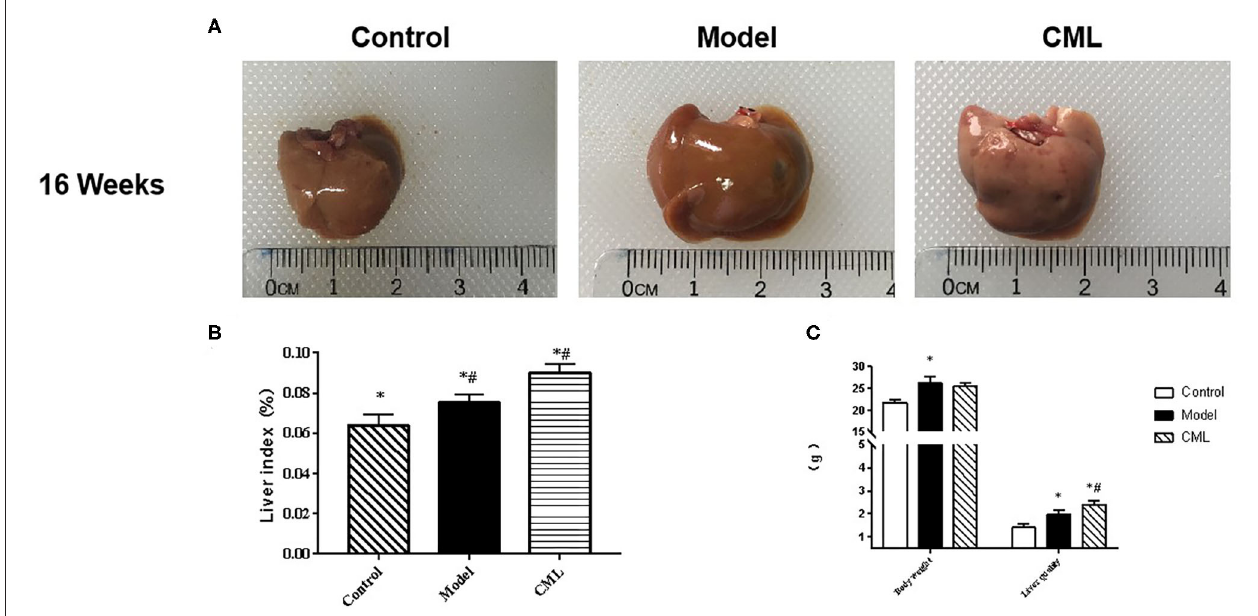
FIGURE 3 | Effect of CML on liver lipid accumulation (A) . Observation of overall liver morphology (B) . Liver body mass indexin ApoE − / − mice (C) . ApoE − / − mice body weight and wet liver weight. * P < 0.05 compared with control group; # P < 0.05 compared with model group.